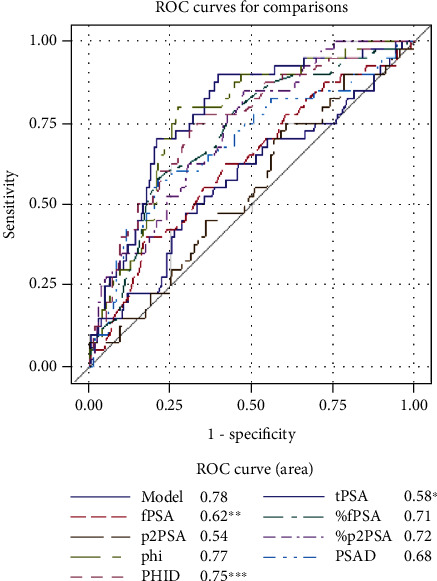
Receiver operating characteristic curves representing the diagnostic ability of blood serum biomarkers in predicting ISUP grade ≥ 2 prostate cancer. Abbreviations: ISUP: International Society of Urological Pathology; fPSA: free prostate-specific antigen; %fPSA: free to total PSA ratio; phi: Prostate Health Index; PHID: phi density; PSAD: PSA density; ROC: receiver operating characteristic; tPSA: total PSA; %p2PSA: p2PSA to fPSA ratio. All significant differences are marked with asterisk (∗), (∗∗), and (∗∗∗): ∗P < 0.05 for tPSA vs. %fPSA, phi, PSAD, and PHID. ∗∗P < 0.05 for fPSA vs. %fPSA, %p2PSA, phi, and PHID. ∗∗∗P < 0.05 for PHID vs. p2PSA and PSAD.